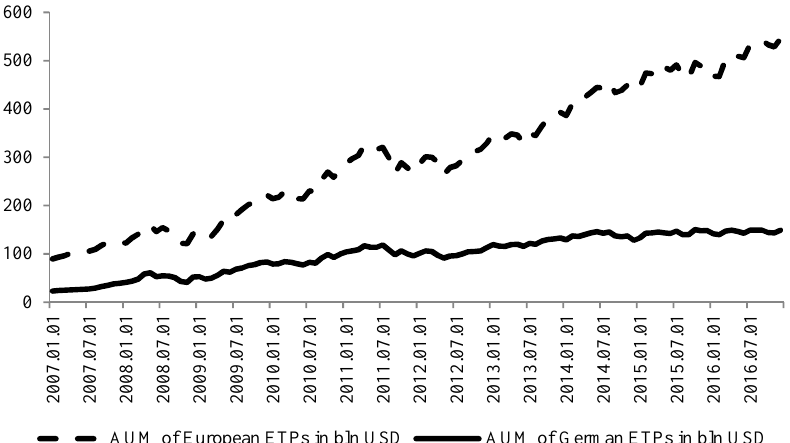
Figure 2. Assets under management of exchange-traded products listed in Europe and Germany according to the location of primary listing (January, 2010 — December, 2016; in bln EUR)